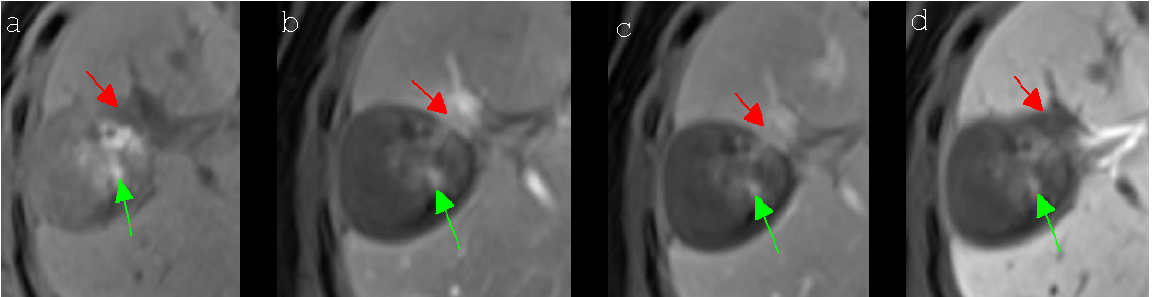
Figure 4. A 64-year-old woman with a local tumor progression in the peripheral ablation zone (segment V/VIII) six months after IRE of an HCC, which presented a typical signal behavior in Gd-EOB-DTPA-based MR imaging. The HCC showed a hypointense signal (red arrow) in the unenhanced T1 MR image ( a ), an obvious hyperintense signal (red arrow) in the contrast-enhanced T1 arterial phase MR image ( b ), a slight wash-out (red arrow) in the contrast-enhanced T1 portal venous phase MR image ( c ) and a hypointense signal (red arrow) in the contrast-enhanced T1 delayed phase MR image ( d ). In addition to this, the central part of the ablation area showed several hyperintense spots (green arrow), which could be detected in all presented MRI sequences ( a – d ), being caused by post-interventional bleeding.